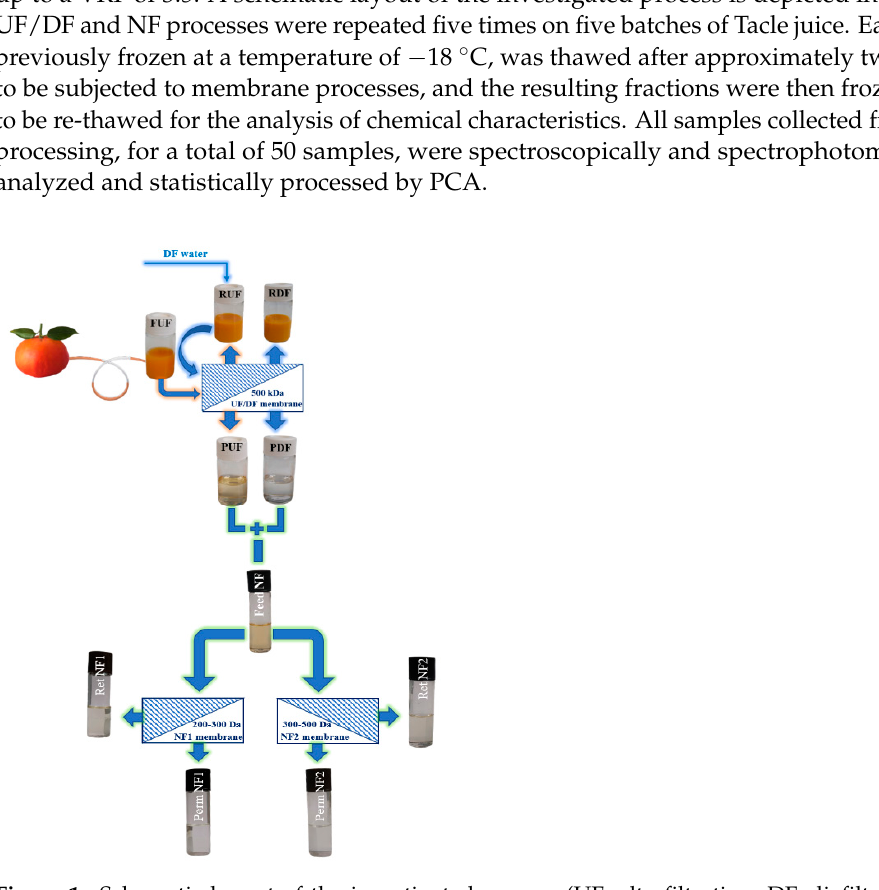
Figure 1. Schematic layout of the investigated process (UF, ultrafiltration; DF, diafiltration; NF, nanofiltration; F, feed; R, retentate; P, permeate).